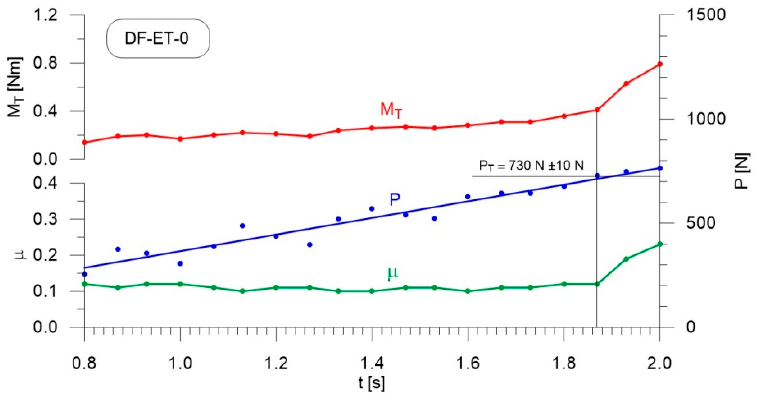
Figure 4. Courses of the load, P, the friction torque, M T , and the friction coefficient, µ, for diesel fuel without ethanol fraction.